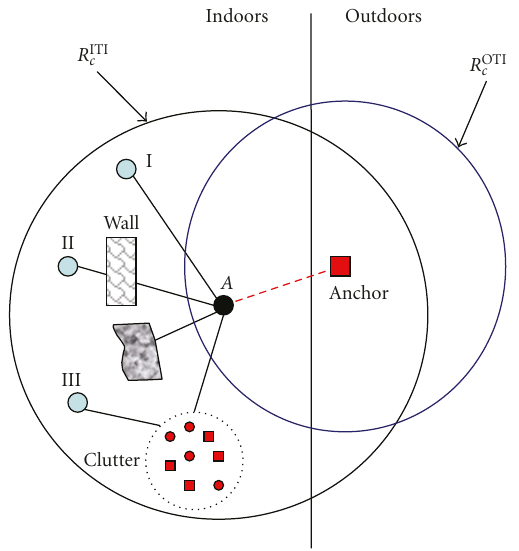
Figure 2: OTI/ITI ranging coverage and the associated ranging error conditions, I: λ (LOS), II: η (NLOS-DP), III: β